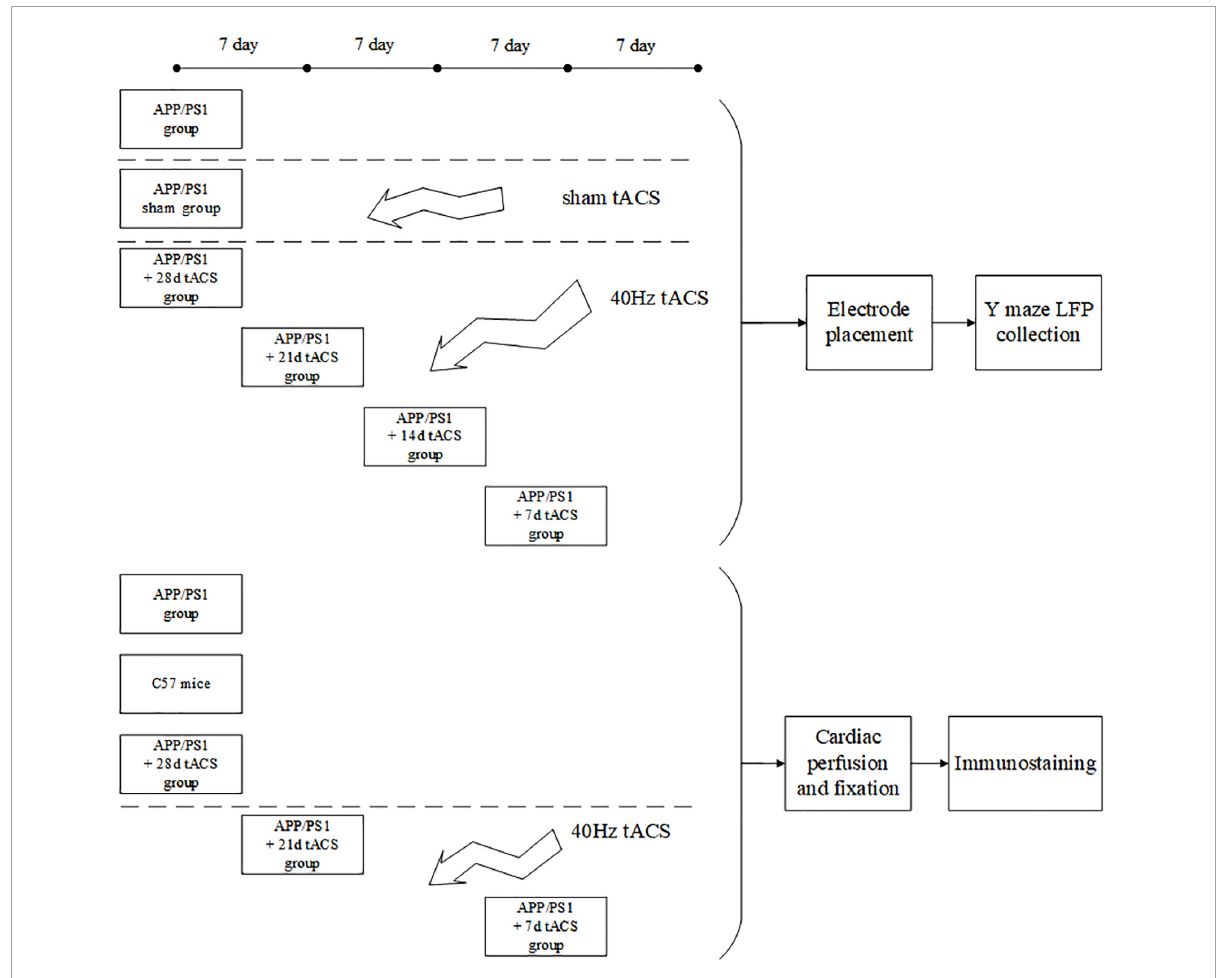
FIGURE1 Experimental flow